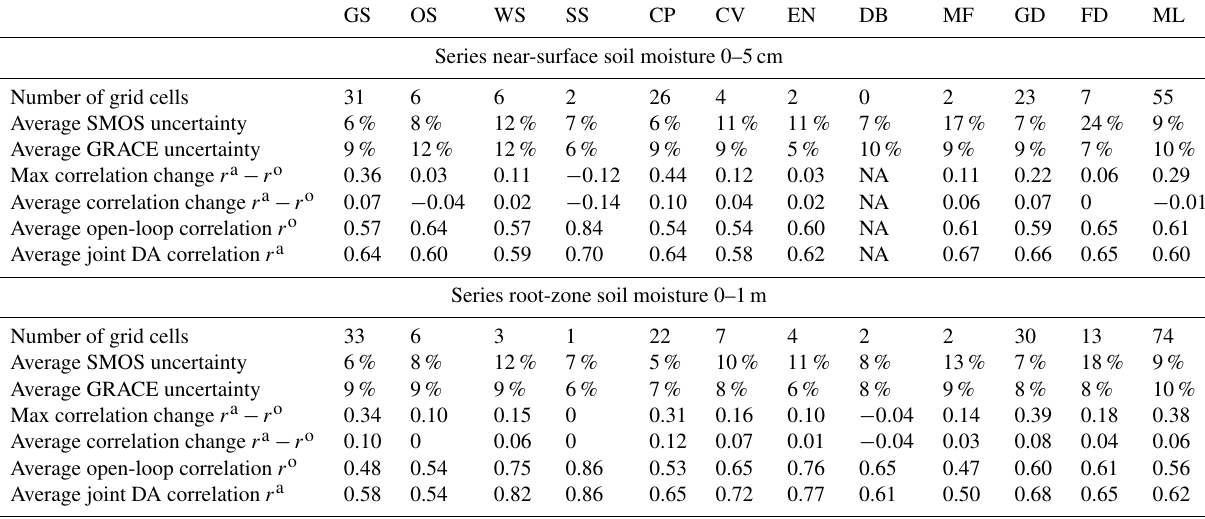
Table 1. Evaluation of near-surface and root-zone soil moisture estimation with ISMN in situ soil moisture observation across land cover